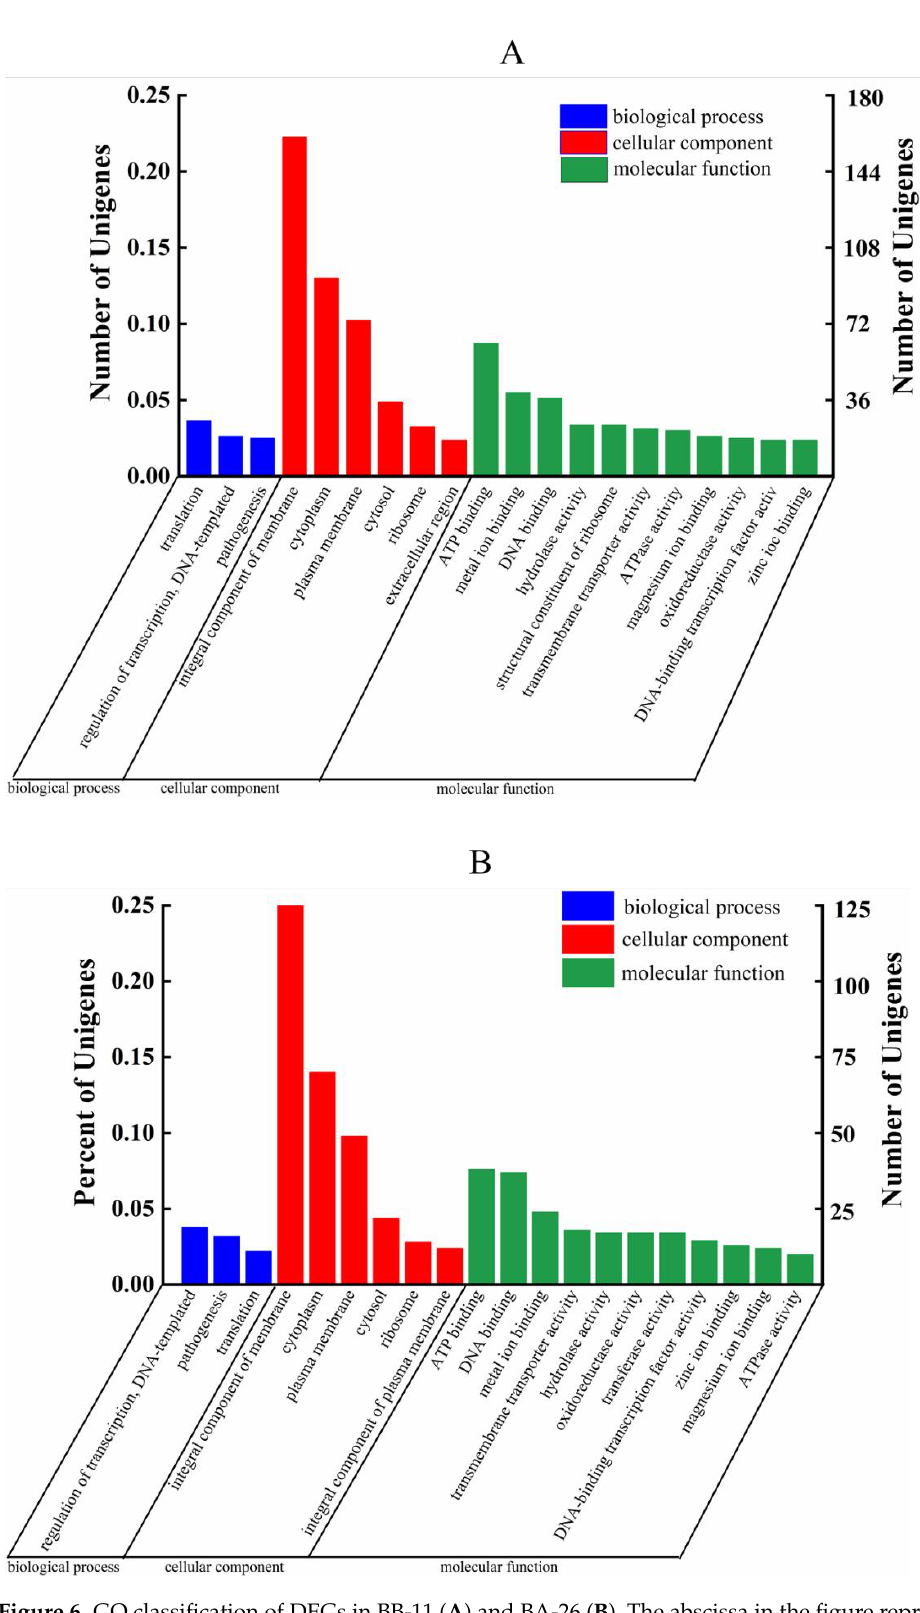
Figure 6. GO classification of DEGs in BB-11 ( A ) and BA-26 ( B ). The abscissa in the figure represents the secondary GO classification terms, the left ordinate represents the percentage of the total number of genes included in the secondary classification, the right ordinate represents the number of genes in the secondary classification in the comparison, and the three colors indicate the three main categories.